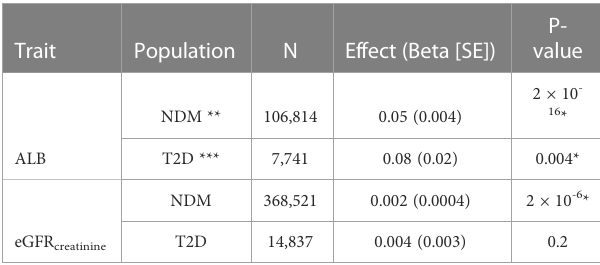
GRS CUBN , A genetic risk score based on a combination of the four CUBN genetic variants (minor alleles); N, sample size; Beta, Beta estimate; SE, standard error; ALB, continuous urinary albumin (mg/L, natural log-transformed); eGFR creatinine , estimated glomerular fi ltration rate (natural log-transformed); NDM, without Diabetes Mellitus; T2D, Type 2 diabetes.*Statisticallysigni fi cant(P<0.05).**outoftotal107,276individualswithcontinuous urinary albumin levels. *** out of total 7,777 individuals with continuous urinary albumin levels.